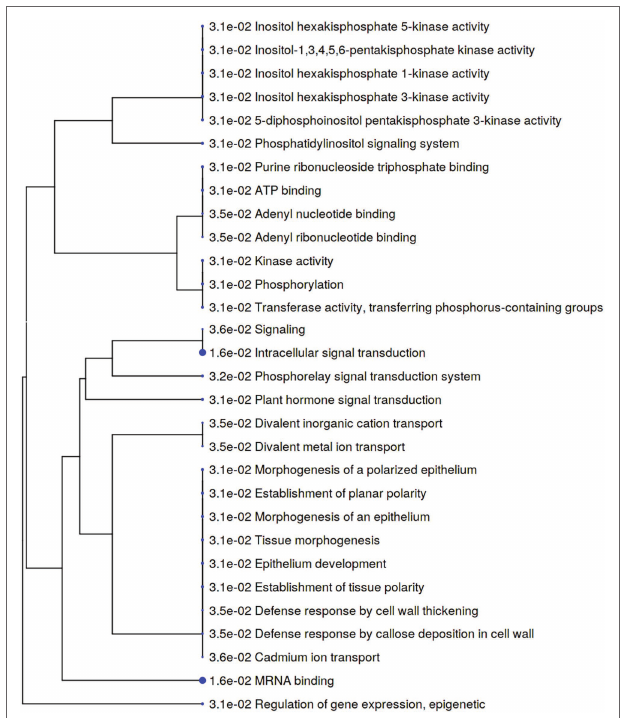
FIGURE 6 | A hierarchical clustering tree summarizing the correlation among significant pathways of the increased differently abundant phosphoproteins in Gladiator (value of p < 0.05, log 2 fold change > 2). Pathways with several shared genes are clustered together. Bigger dots (blue dots) indicate more